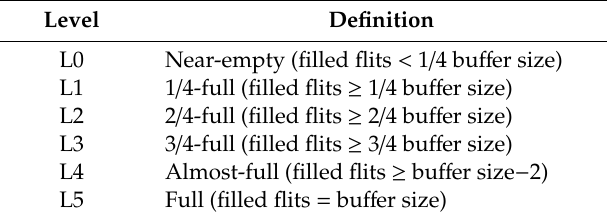
Table 2. Bu ff er Fill Level